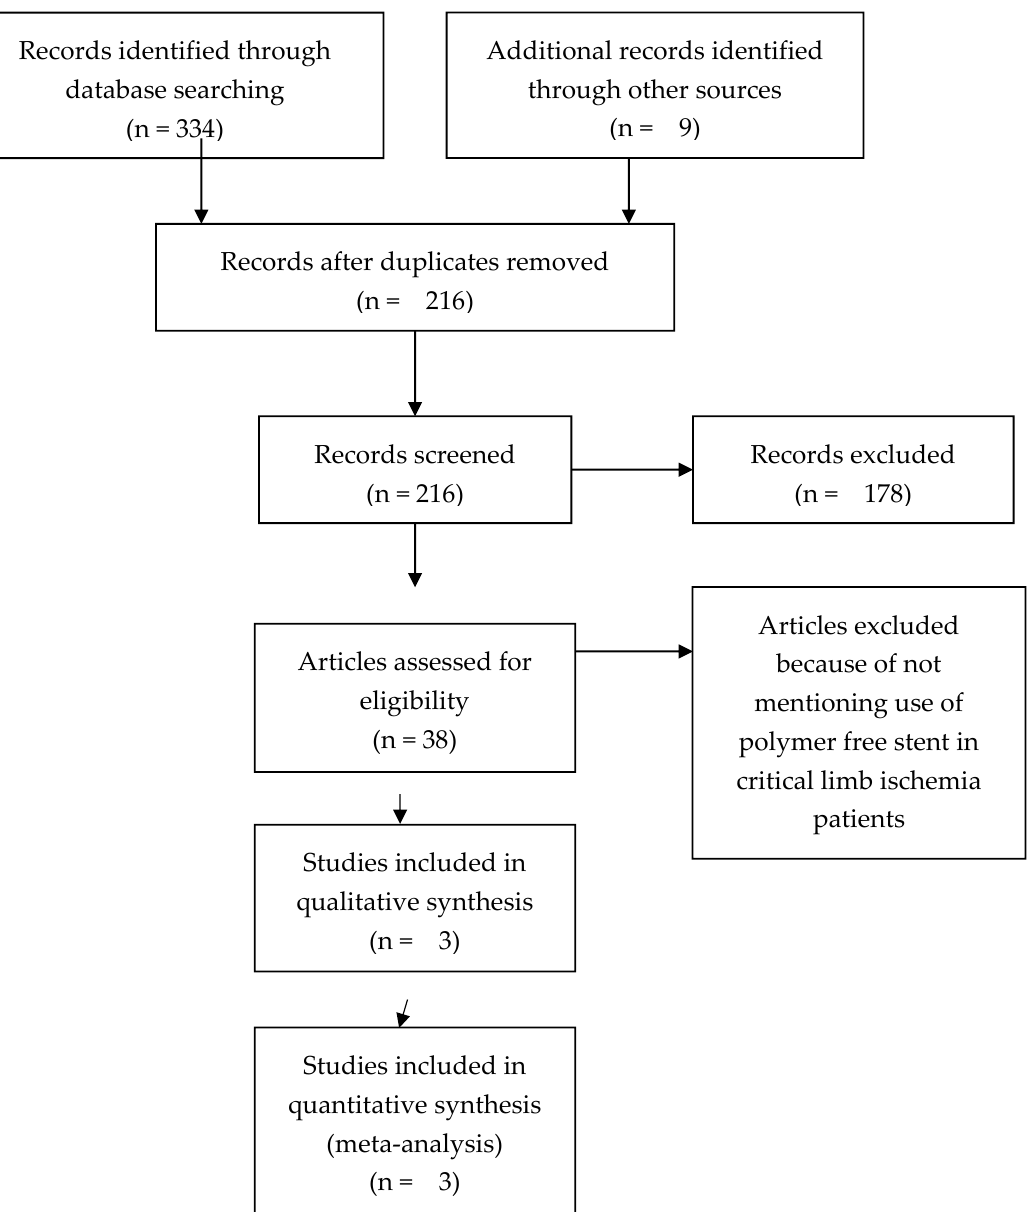
Figure 4. PRISMA flow chart showing study search and